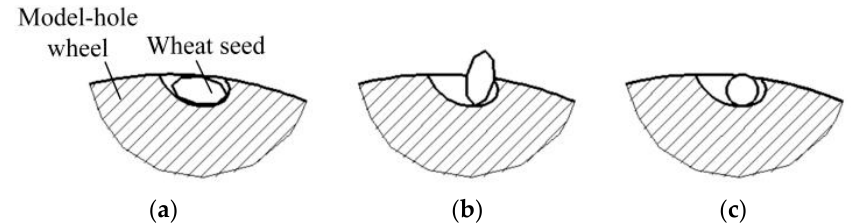
Figure 3. Three filling positions of wheat seeds. ( a ) “Flat”; ( b ) “Lateral”; ( c ) “Erect”. Through theoretical analysis, the occurrence probability of different filling postures